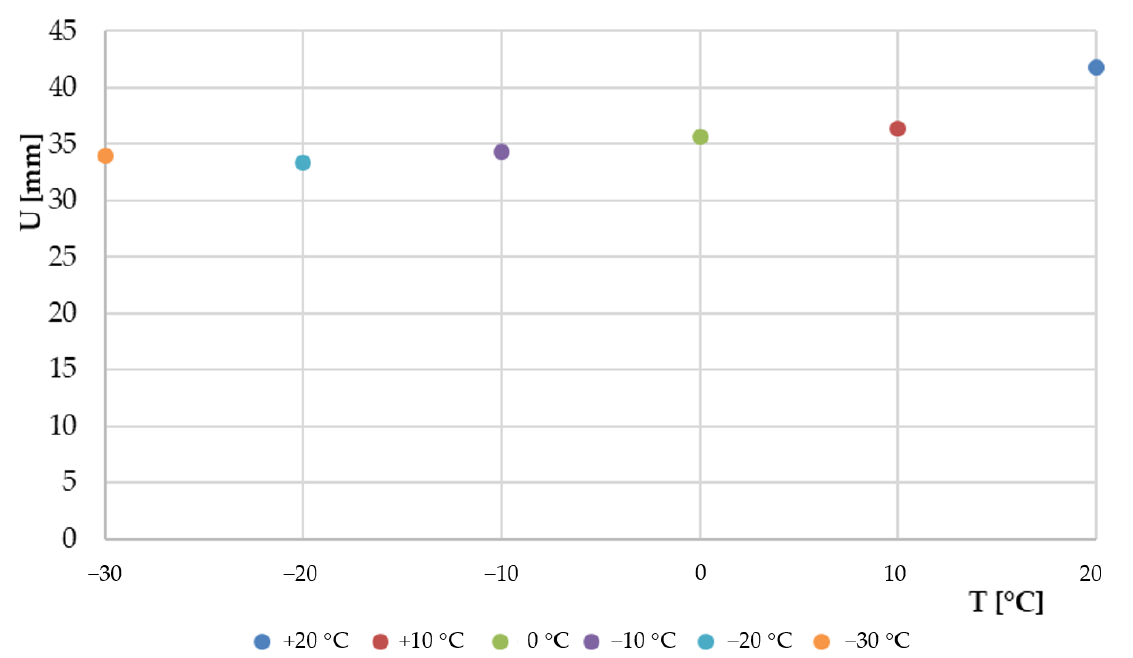
Figure 8. Displacement of windscreen int the point of impactor impact — temp. = − 30 °C (t = 8 ms).